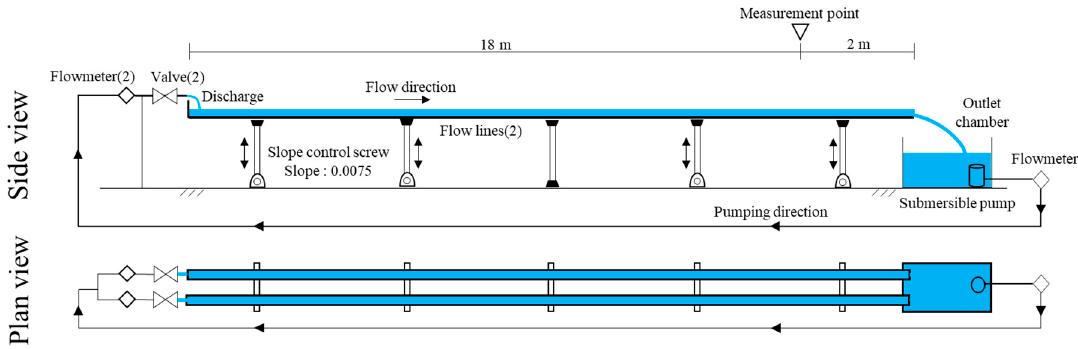
Figure 3. Configuration of sewer pipelines for tractive force test.